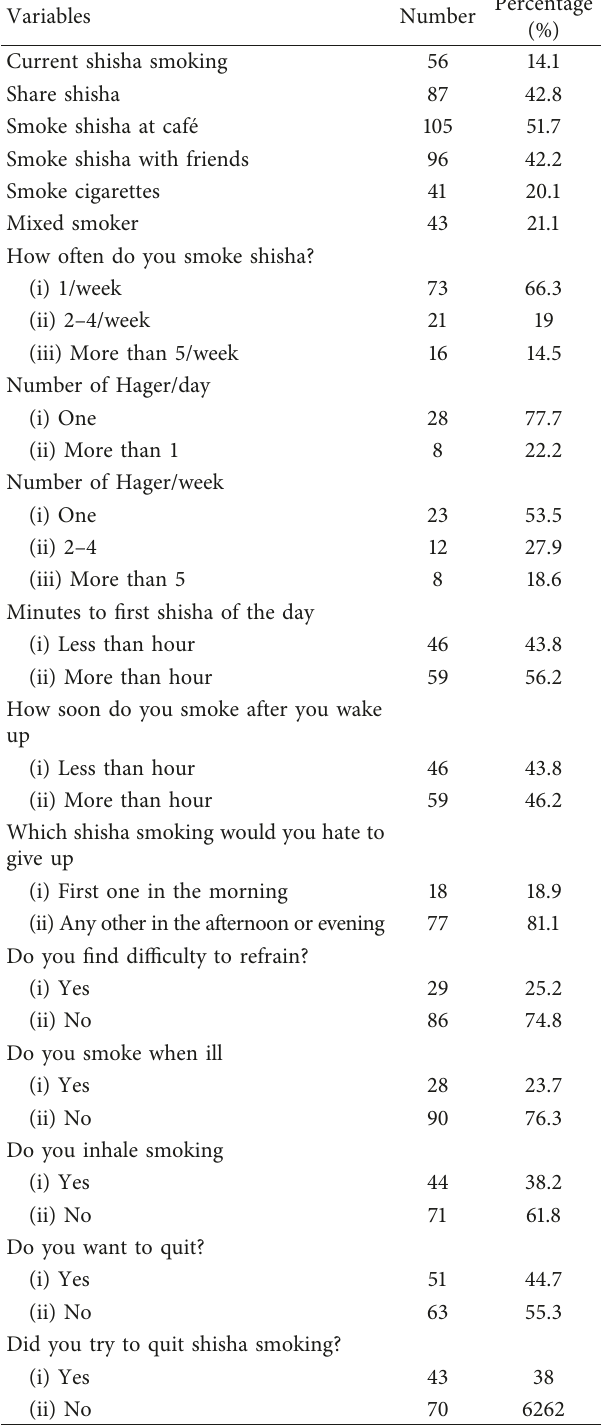
Table 11: Participant’s smoking habits and dependence (current shisha